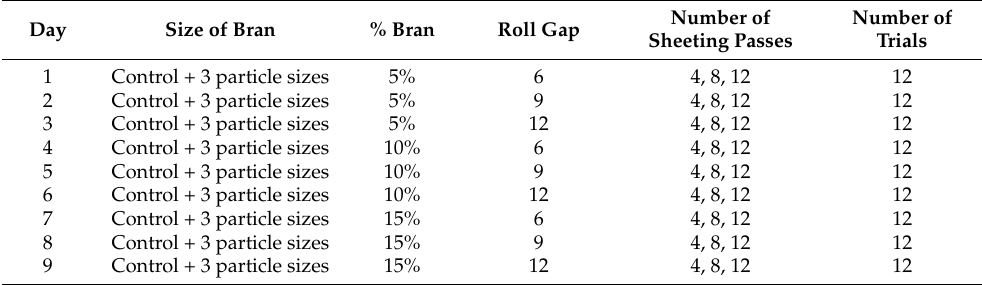
Table 1. Experimental plan for investigating effects of bran particle size (Coarse, Medium and Fine), level, roll gap and number of sheeting passes on dough